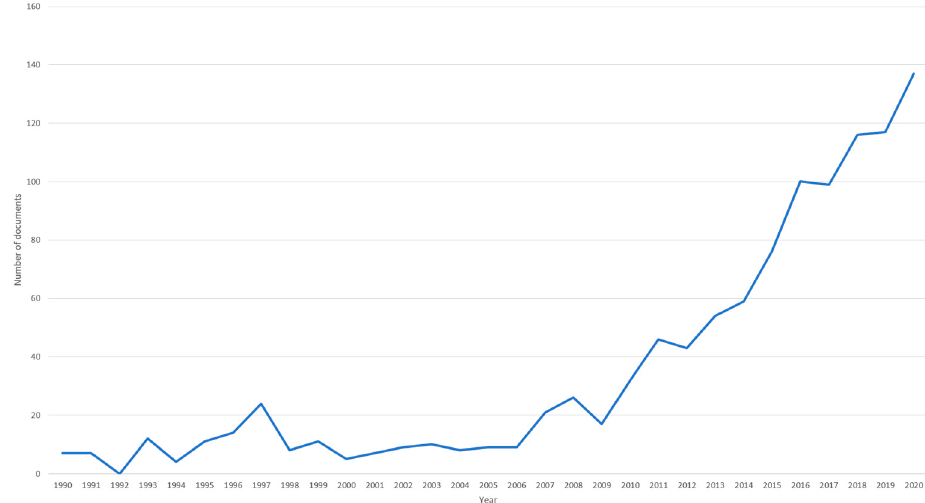
Figure 8. Documents per year for alginate or ulvan (Appendix B—vii).